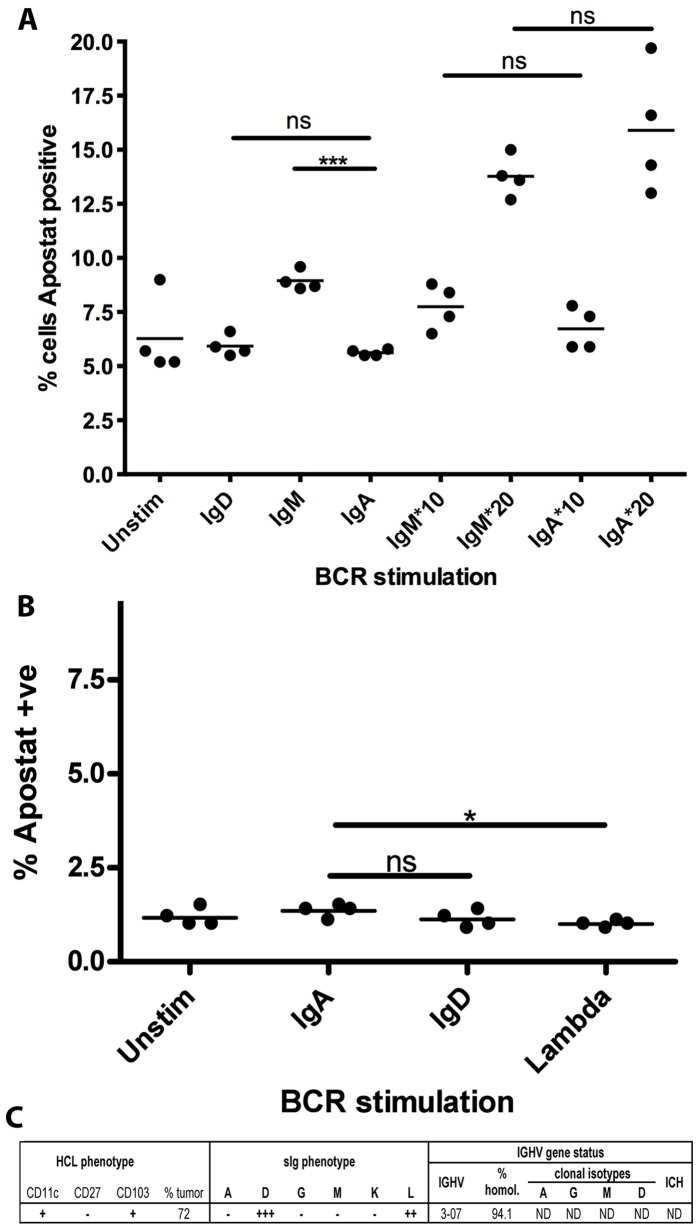
In IgD+ mult-HCL and IgD+ s-HCL anti-sIgD stimuli do not trigger apoptosis.For IgD+ mult-HCL Case 13 (functional isotypes for ERK1/2 phosphorylation: D++, G+, M+, λ++) material was available to evaluate stimulation with soluble goat F(ab’)2 anti-sIgD/λ antibodies or anti-sIgA as control (isotype not functional). Panel A shows representative data from 1 of 2 replicate experiments assaying apoptosis in CD19HICD11cHICD103+ tumor cells following stimulation. Anti-sIgD stimulation did not induce apoptosis as compared to the non-functional isotype control. Stimulation with soluble anti-sIgM did induce a low but significant increase in apoptosis as this isotype is functional. This lack of apoptotic effect in response to IgD stimulation was further investigated in a single sIgD+ve s-HCL Case 15 (phenotype summarised in Panel C). Stimulation via sIgD or slgλ in this s-HCL case did not induce apoptosis of CD19HICD11cHICD103+ tumor cells either in response to soluble (Panel B) or immobilised anti-sIg (data not shown). Data were analysed in PRISM using student’s t-test with Welch’s correction. P-values are summarised as ns>0.05, *0.01–0.05, **0.01–0.001, ***0.001–0.0001, ****<0.0001.